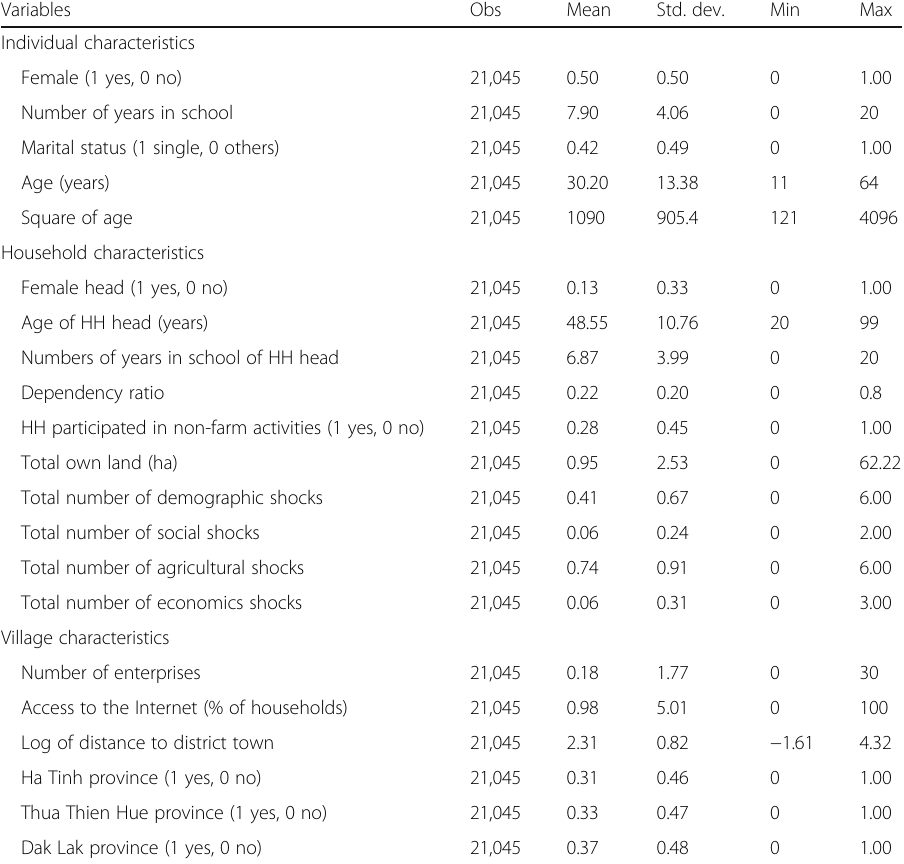
Table 6 Summary statistics of independent variables of the random-effect Tobit regression